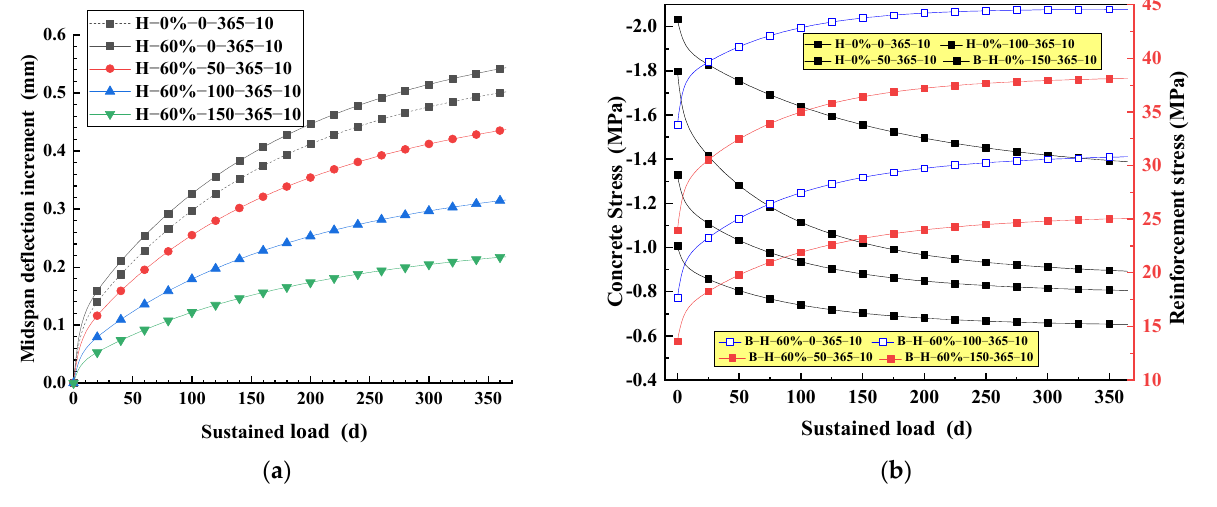
Figure 18. The creep of the concrete with different heights of reinforcement under a positive bending moment: ( a ) the midspan deflection increment and ( b ) the section stress. As shown in Figure 18a, the deflection of damaged unstrengthened beam H-60%-0- 365-10 increases under the effect of creep compared with undamaged beam